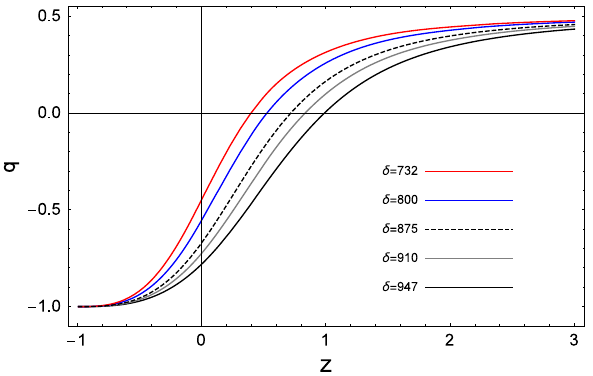
Fig. 4 The behavior of deceleration parameter for D 2 = 0 . 3136, (cid:8) 0 = 0 . 315 (the current value of (cid:8) m (cid:8) m ratio is obtainable, depending on the values of C 2 and (cid:8) κ (cid:7)